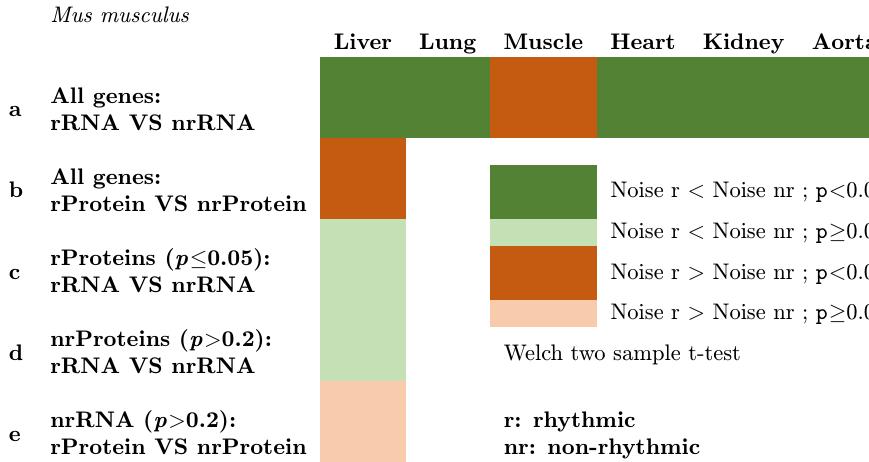
Table 1. Simplified table showing the results of the Welch two sample t-test testing the hypothesis that the noise is equal between rhythmic versus non-rhythmic transcripts (a), or proteins (b), or between rhythmic versus non-rhyth- mic transcripts among rhythmic proteins (c) or among non-rhythmic proteins (d), and between rhythmic versus non- rhythmic proteins among genes with constant transcripts (e). F � is an estimation of the noise based on Barroso et al. method [28]. Complete results are provided in S5